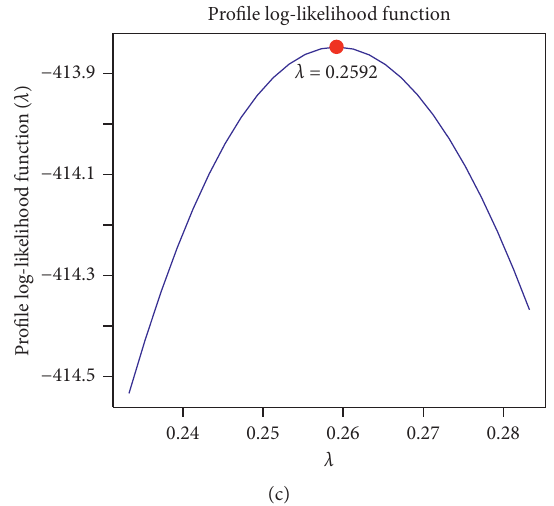
Figure 9: The profile of the log-likelihood function for bladder cancer data.